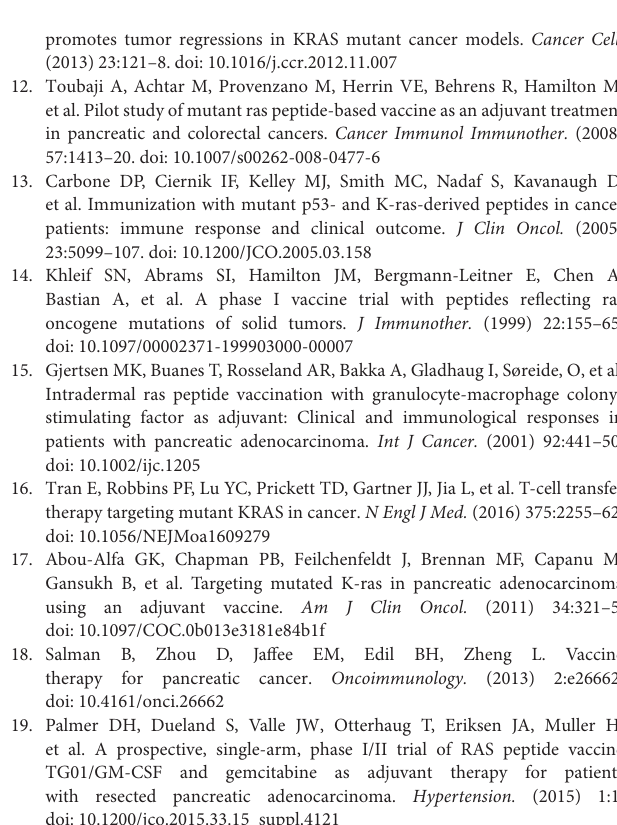
Supplementary Figure S1 | Tumor growth curve of individual mice in preventive and therapeutic CT26model. (A) Tumor growth curve of individual mice in low-dose CT26 model. (B) Tumor growth curve of individual mice in therapeutic CT26 model. Supplementary Figure S2 | Tumor infiltration of CD8 + T cells in the tumor tissue. Mice from the therapeutic model were sacrificed when tumor size reached nearly 1,000–1,500 mm 3 . (A) Representative images of IHC staining for tumor-infiltrating CD8 + T cells. (B) The density of CD8 + T cells were measured by ImageJ. Data are presented as means ± SD. ∗∗∗ p < 0.001, ∗ p < 0.05, Student’s T